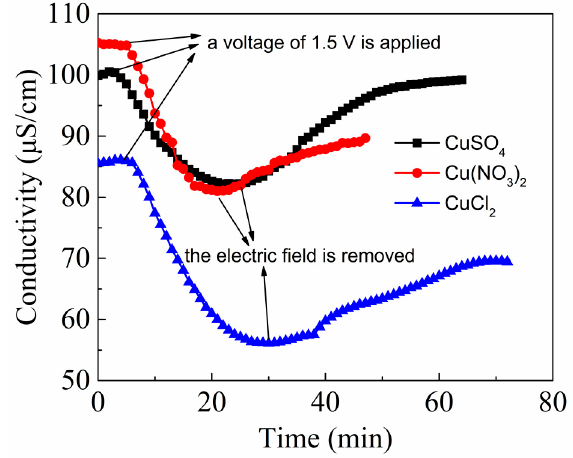
Figure 4. The adsorption curves of CA electrodes for three copper solution. Table 3. The salt adsorption capacity (SAC) of CA electrodes for different copper solution. Anion